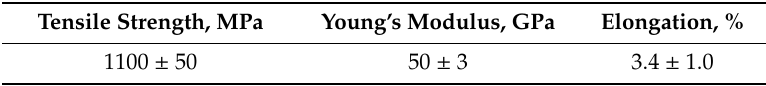
The mechanical properties of the UHMWPE films used to prepare the cylindrical multi-UHMWPE forms samples ( ± standard